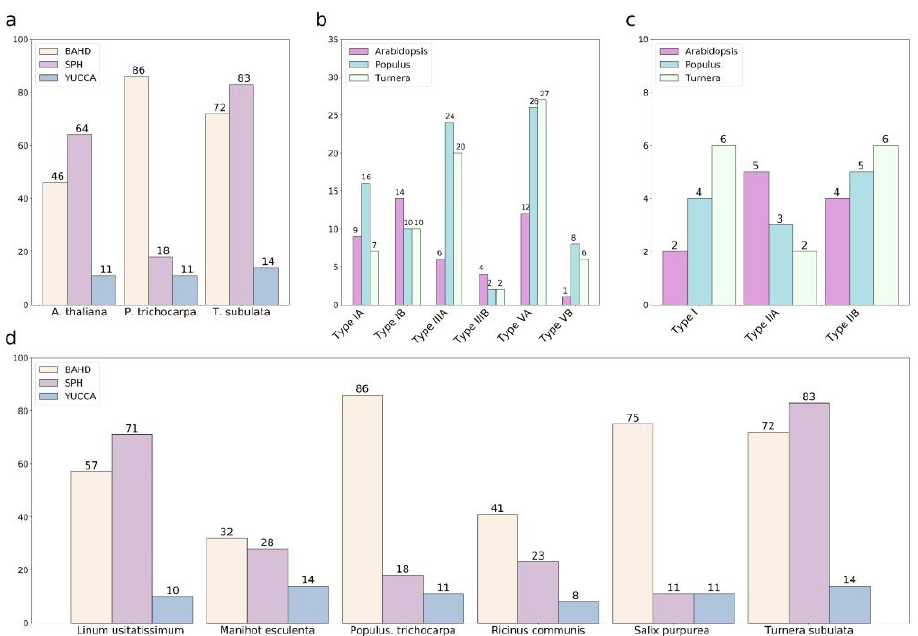
Figure 4. Phylogenetic relationship of the BAHD gene family in Turnera subulata . Generated using MEGA11 [30]. Values at nodes represent proportions from 1000 bootstrap replicates. Additional information related to motifs and intron/exon structure can be found in Supplementary Figure S6.